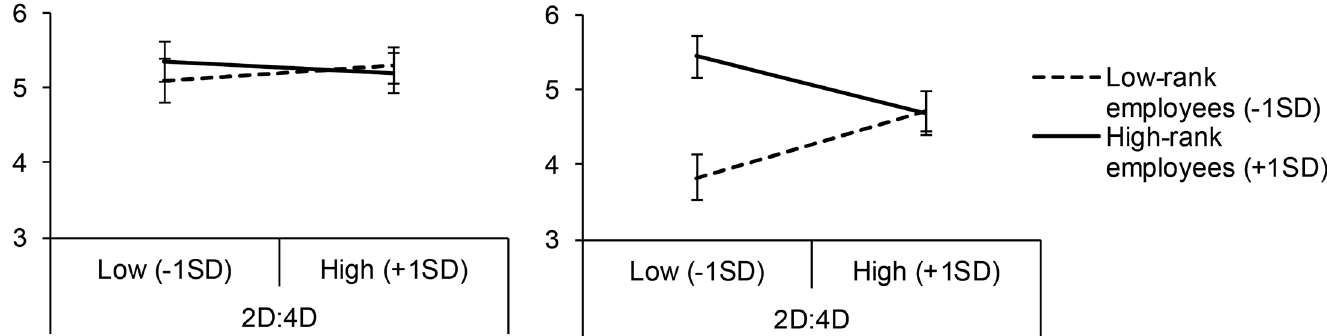
Fig 1. Estimated means of people’s tendency to use voice, as a function of 2D:4D and rank within the organizational hierarchy. Please note that these estimates were computedbasedon the generallinear model describedin the main text (so, not by splittingthe dataset into two groups). Left panel: voice within team. Right panel: voice within organization.Error bars represent standarderrors aroundthe estimate.